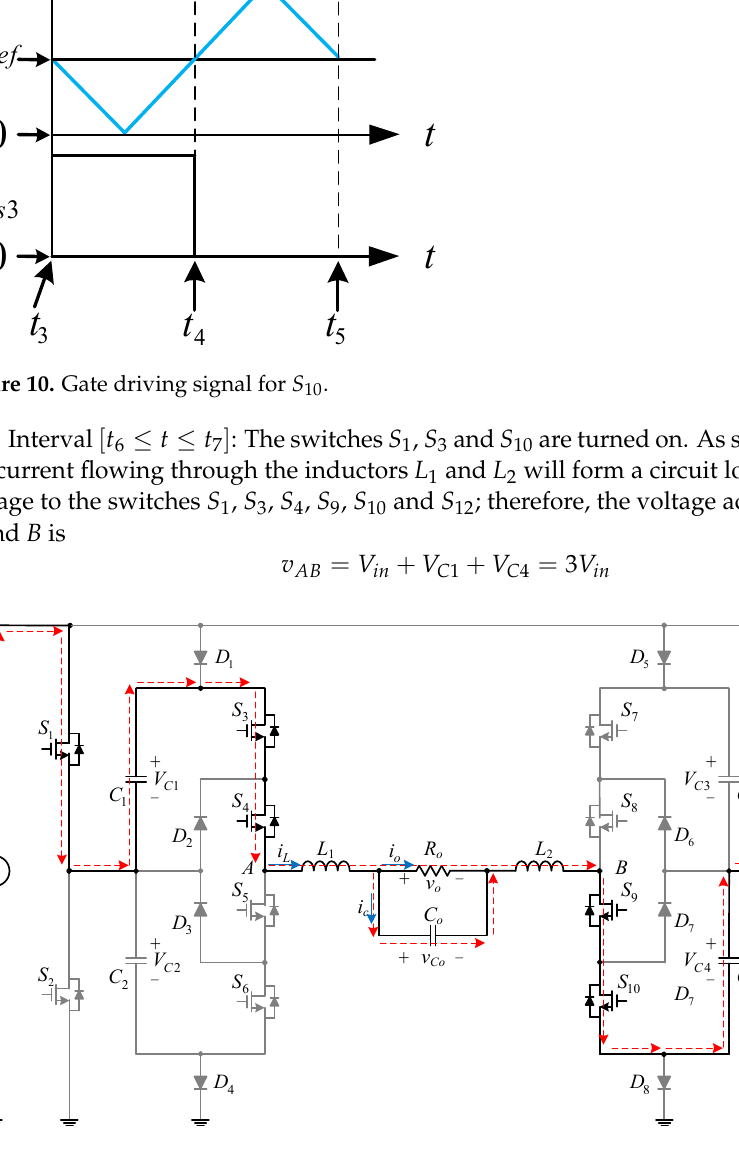
Figure 11. Current flow direction of stage III when the switch S 10 is on. Interval [ t 7 ≤ t ≤ t 8 ] : The switch S 10 is off, but the switches S 1 and S 3 are on. As shown in Figure 12, the current flowing through the inductors L 1 and L 2 will form a circuit loop from the input voltage to the switches S 1 , S 3 , S 4 , S 9 , S 12 and the diode D 7 ; therefore, the voltage across the terminals A and B is From the above analysis, we can see that the proposed 7-level DC-AC converter has the voltage gain of 3, which can be obtained based on (7):